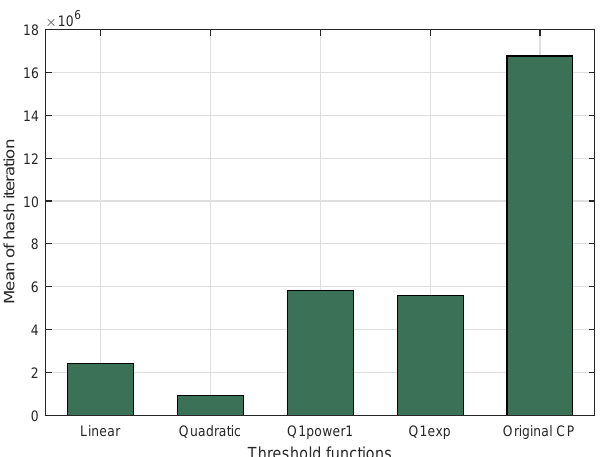
Figure 11. Mean number of hash iterations for DCP with four different threshold functions and original Cipher Puzzle.